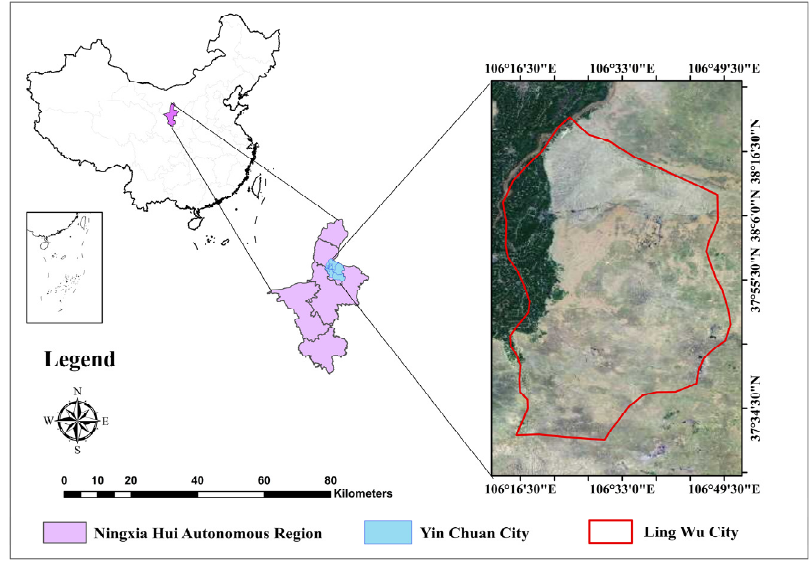
Figure 1. Location of the coal mine.